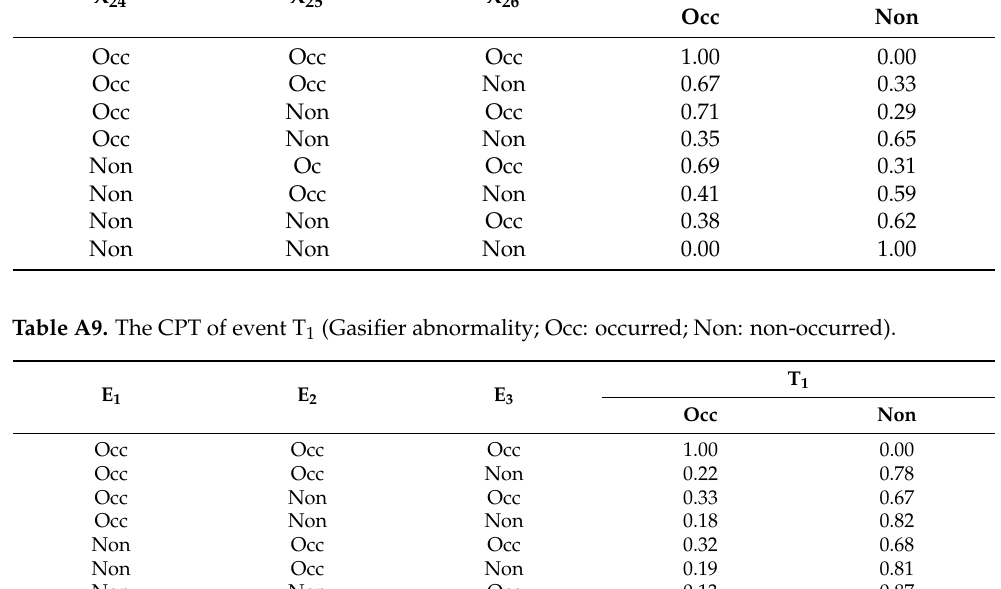
Table A8. The CPT of event I 2 (Unintentional destruction; Occ: occurred; Non: non-occurred). X 24